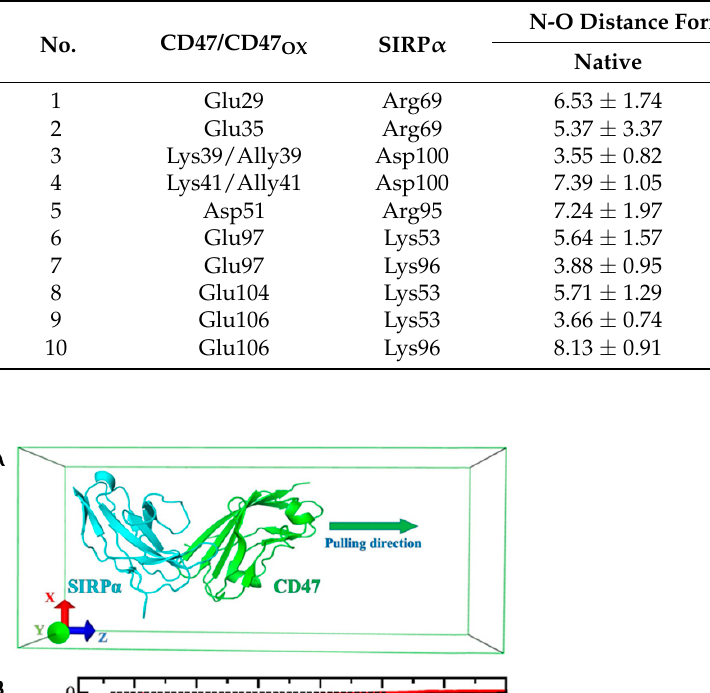
Table 1. Calculated salt bridge distances formed between CD47/CD47 OX and SIRP α systems.